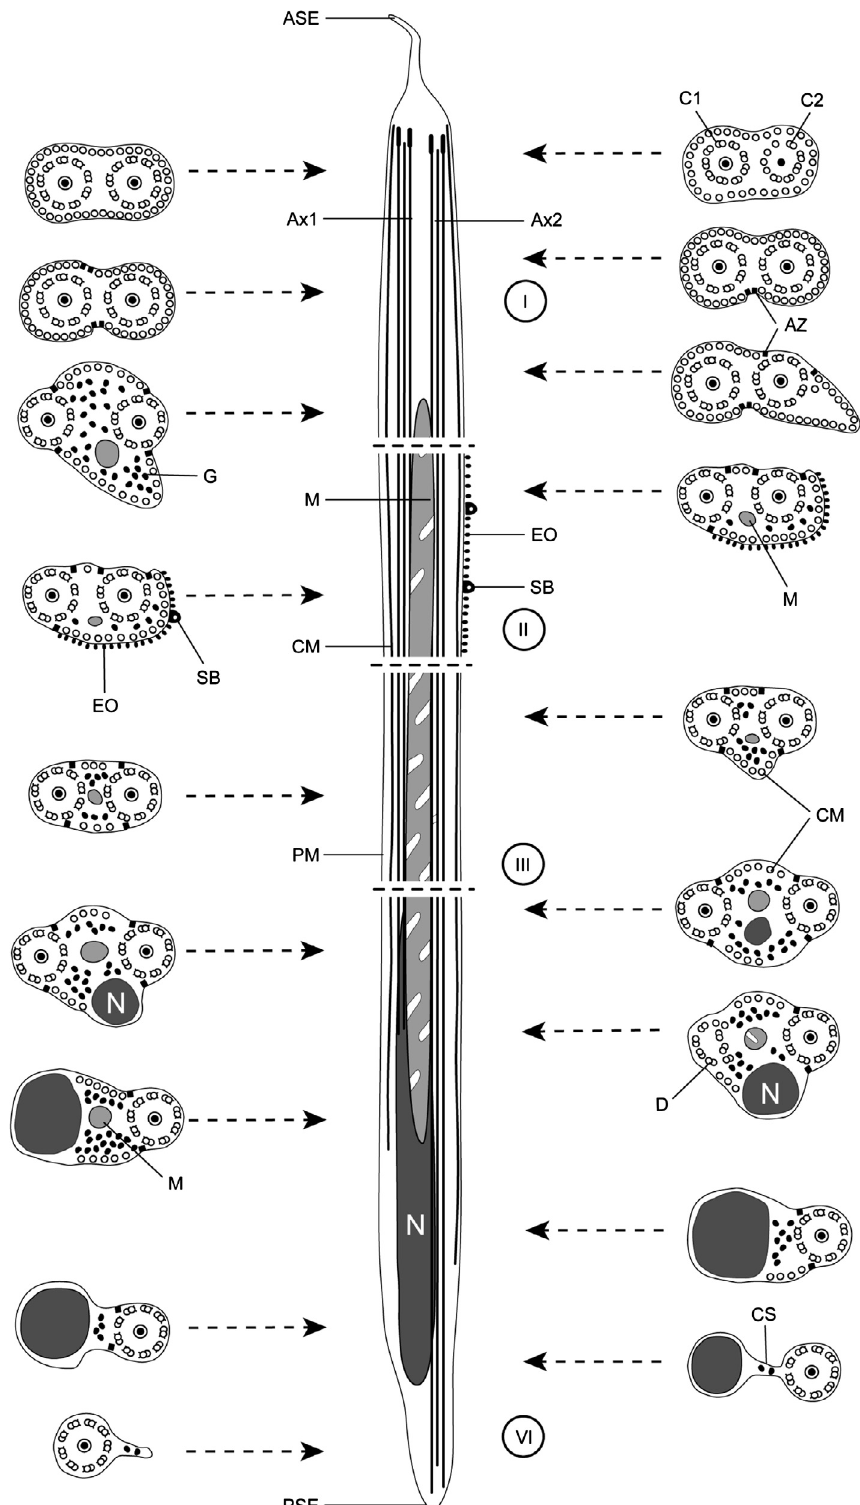
Figure 4. Schematic reconstruction of ultrastructural organisation of the mature spermatozoon of Collyricloides massanae . ASE, anterior spermatozoon extremity; Ax1, first axoneme; Ax2, second axoneme; AZ, attachment zones; C1, centriole of the first axoneme; C2, centriole of the second axoneme; CM, cortical microtubules; CS, cytoplasmic stalk; D, doublets; EO, external ornamentation of the plasma membrane; G, granules of glycogen; M, mitochondrion; N, nucleus; PM, plasma membrane; PSE, posterior spermatozoon extremity; SB, spine-like